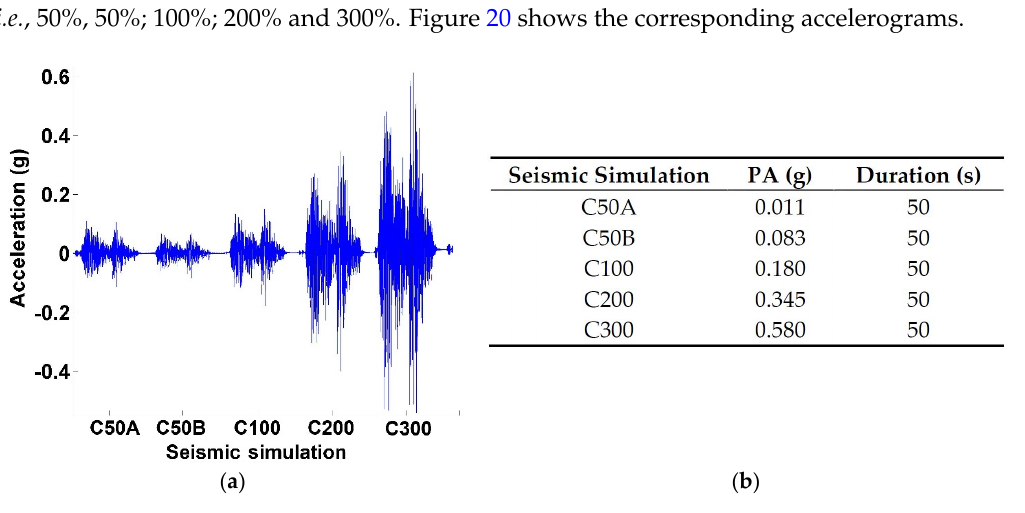
Figure 19 . RC frame with AE sensors (S1 to S20). ( a ) Plan (bottom view). ( b ) Elevation. AE signals were acquired with twenty VS30 ‐ V AE sensors (Figure 19), recording the waveform with a sampling frequency of 2.5 MHz and a detection threshold of 50 dB AE and preamplifiers of 34 dB AE . In addition, the steel reinforcement was instrumented with 192 strain gauges and 10 uniaxial accelerometers, and nine displacement transducers were installed on the RC specimen in order to measure the in ‐ plane translations and the inter ‐ story drifts in the direction of the seismic loading.